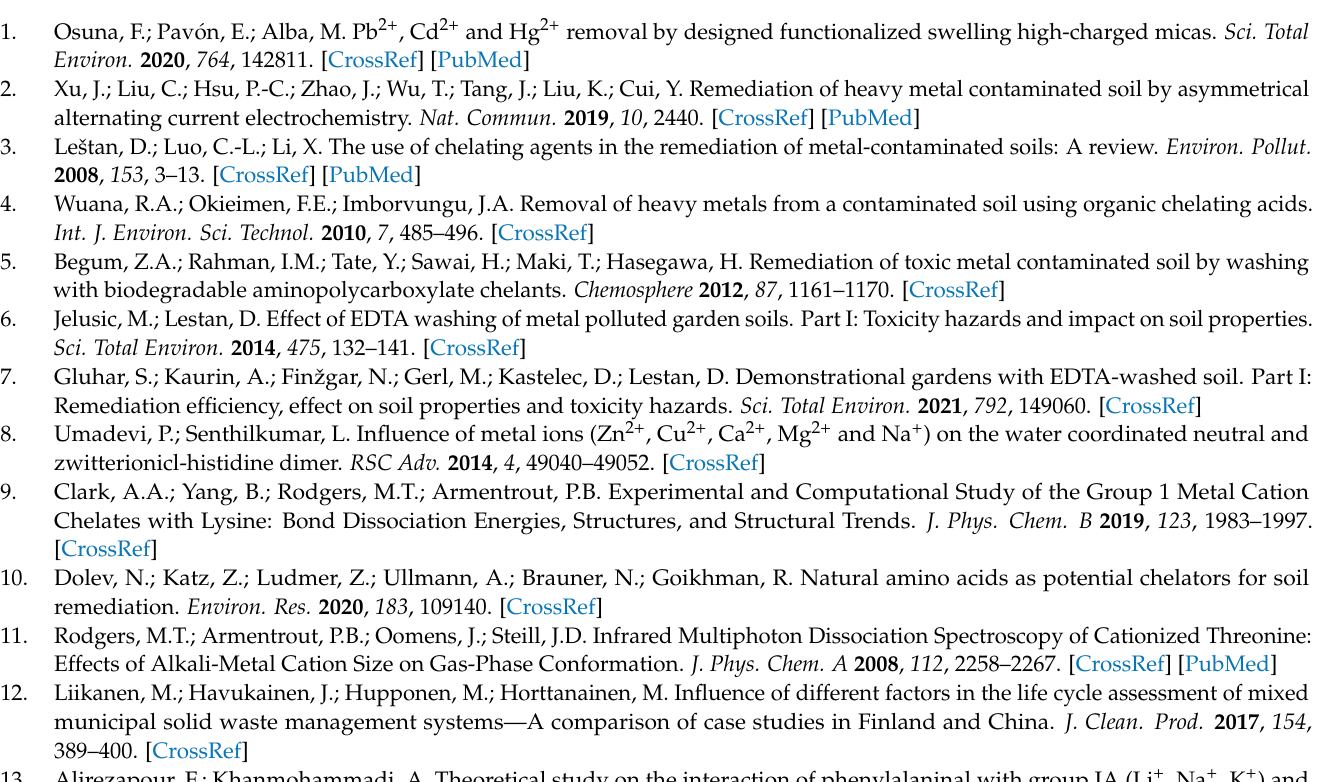
Table S1: The relative Gibbs free energy ( ∆ G ) of AAs-metal cations structures; Text S1. The cartesian coordinates information of converged